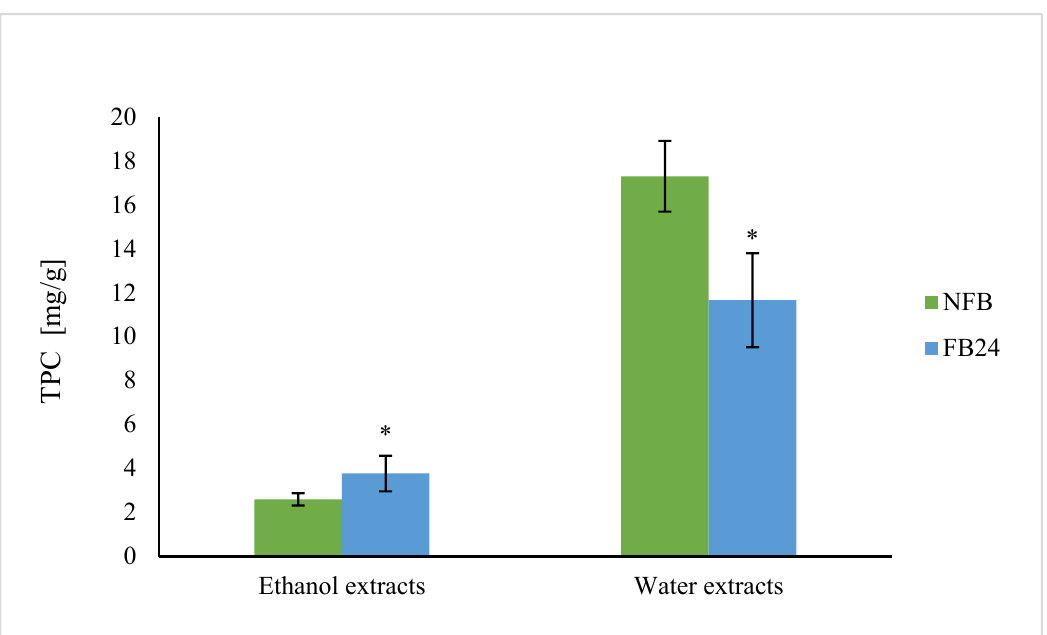
Figure 3. TPC of water and ethanol extracts of NFB and FB. Data represent mean values ± SD. Asterisk (*) indicates statistically significant difference between FB and NFB for particular extract ( p < 0.05).